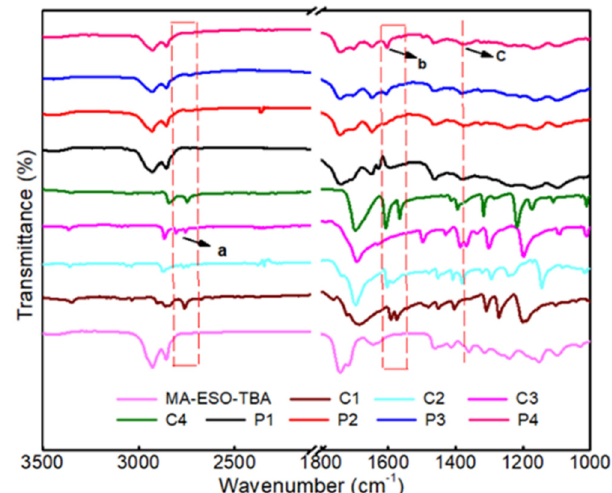
Figure 4. FTIR spectra of the four films (P1, P2, P3, and P4), four crosslinkers (C1, C2, C3, and C4) and acetoacetylated soybean oil, and the peaks of a is CHO stretching frequency, b and c are the peaks of benzene rings.